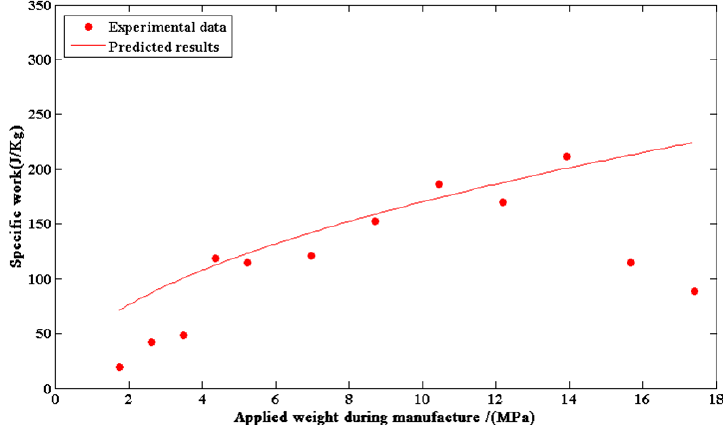
Figure 5. Maximum specific work of the TCP muscles with different fabrication load